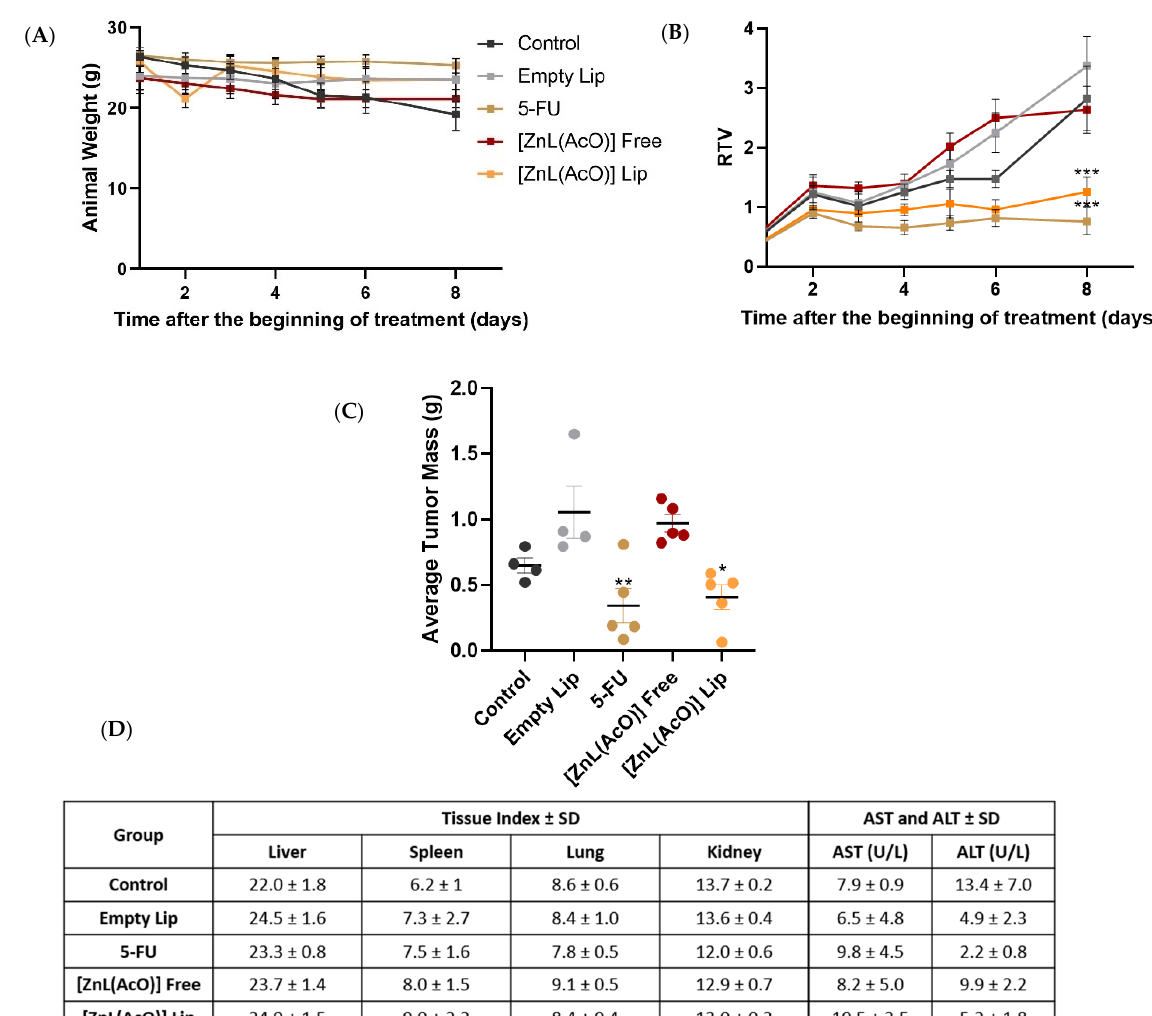
Figure 7. Therapeutic effect of different formulations in a syngeneic murine colon cancer model. Tumor induction was performed by an s.c. injection of 1 × 10 6 CT-26 cells. Five experimental groups were established: Control (mice receiving PBS); Empty Lip (empty liposomes); 5-FU (5-Fluorouracil); [ZnL(AcO)] Free, and [ZnL(AcO)] Lip (selected [ZnL(AcO)] liposomal formulation F4). Treated mice received intravenous (i.v.) administrations of the tested formulations at a dose of 5 mg/kg of body weight, with the exception of 5-FU, which was administered at 15 mg/kg. ( A ) Animal weight; ( B ) Relative tumor volume (RTV); ( C ) Tumor mass weight of each animal and the respective average (g) for each group under study on the sacrifice day. ( D ) In vivo safety parameters of all animal groups under study: tissue indexes and aspartate transaminase (AST) and alanine transaminase (ALT) values. Tumor volume was calculated according to the formula: V (mm 3 ) = (L × W2)/2, where L and W represent the longest and shortest axes of the tumor, respectively. RTV was determined for each animal as the ratio between the volumes on the indicated day and the volumes at the beginning of treatment. Results are expressed as means ± SD (*** p < 0.001 vs. control, [ZnL(AcO)] Free, and Empty Lip, ** p < 0.01 vs. [ZnL(AcO)] Free and Empty Lip, * p < 0.05 vs. [ZnL(AcO)] Free and Empty